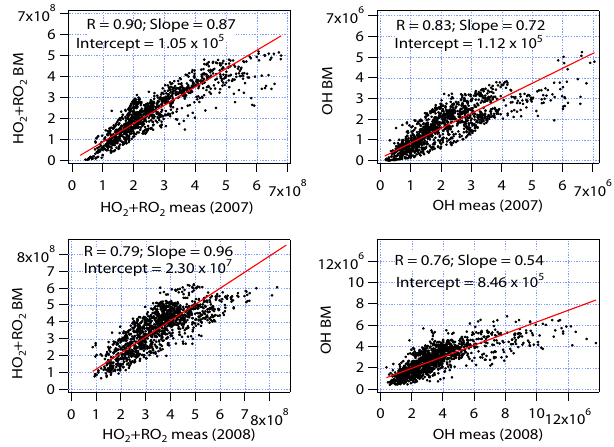
Fig. 4. HO 2 +RO 2 and OH predictions from the base mode (BM) plotted versus the observations in 2007 and 2008. The data are av- erage on a 10min time base. The correlation coefficient (R) and the slope and intercept from an equally weighted bivariate regression (red line) for each panel are also denoted in the figure. The units of OH and HO 2 +RO 2 concentrations are moleccm − 3 .